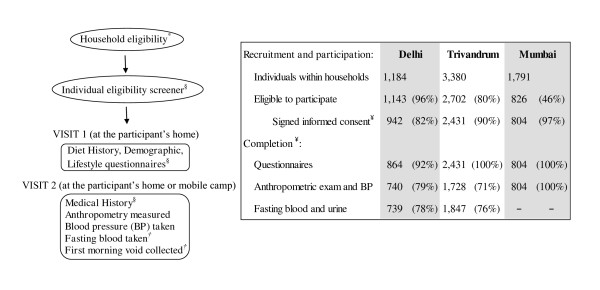
India Health Study (IHS): Design, visit flow, and participation rates. *Participant's household selection was stratified by religion, as well as urban-rural status in Trivandrum only. Both Delhi and Mumbai centers are considered to be entirely urban. Religious groups are not evenly distributed throughout the country; therefore, higher concentrations of Muslim and Christian households were recruited from Trivandrum. §All questionnaires were administered by trained field staff via interview. †In Mumbai, no biological samples were collected and all information was collected in the first visit. ¥Denominator for completion rates